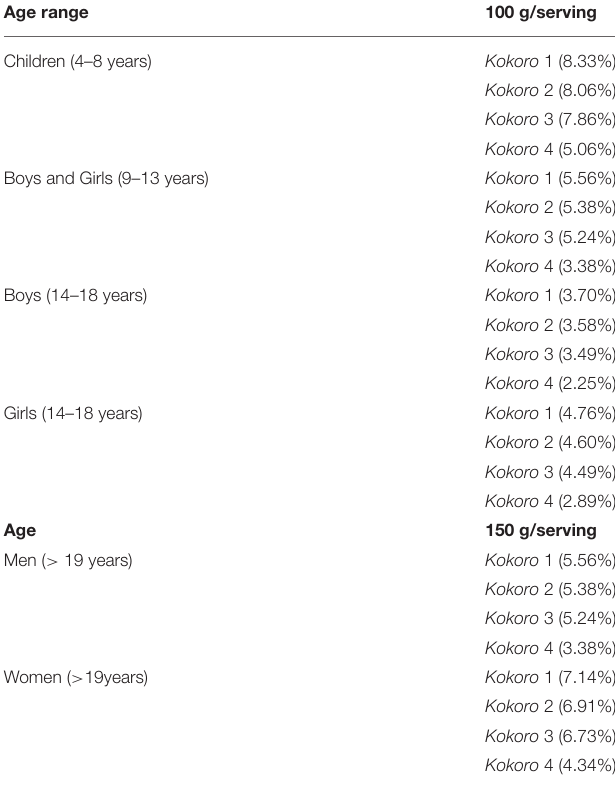
TABLE 6 | Percentage contribution of PVA- Kokoro to the daily intake of vitamin